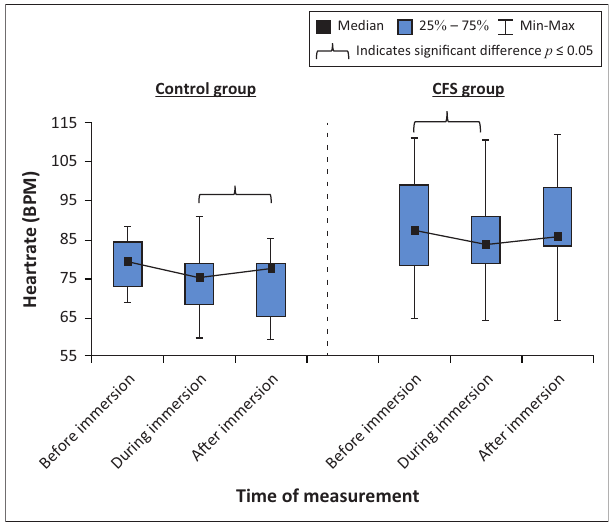
FIGURE 3: Box and whisker plot showing changes in heart rate before, during and after immersion of the control and chronic fatigue syndrome groups.